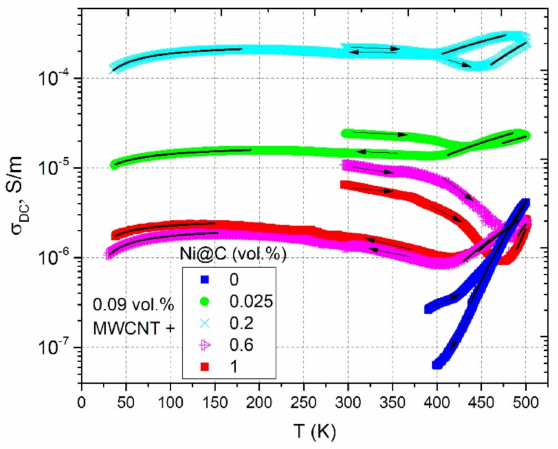
Figure 13. Temperature dependence of the DC conductivity of hybrid Ni@C/MWCNTs/epoxy composites with fixed MWCNTs concentration of 0.09 vol.% and different Ni@C content. Solid lines at high and low temperatures correspond to approximations according to Equations (3) and (8),